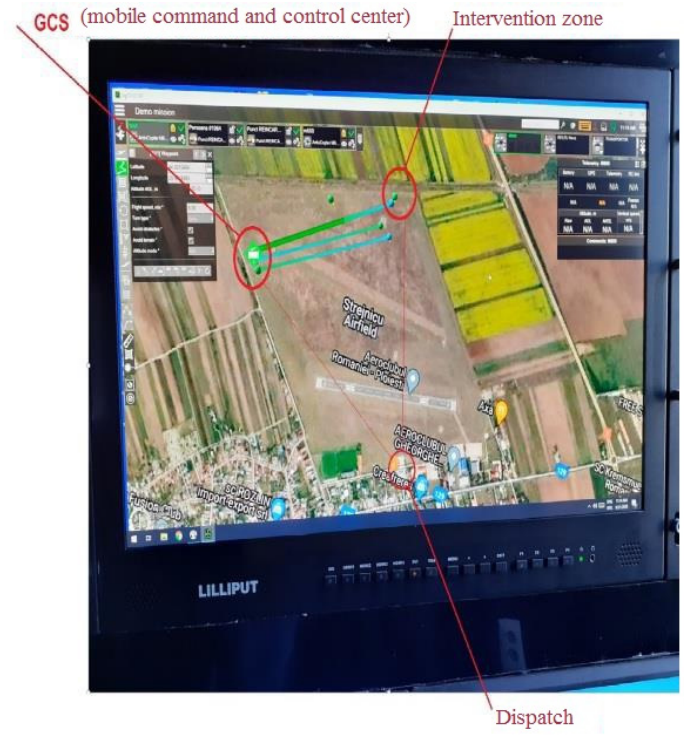
Figure 7. 19 Sol/UAV project test.